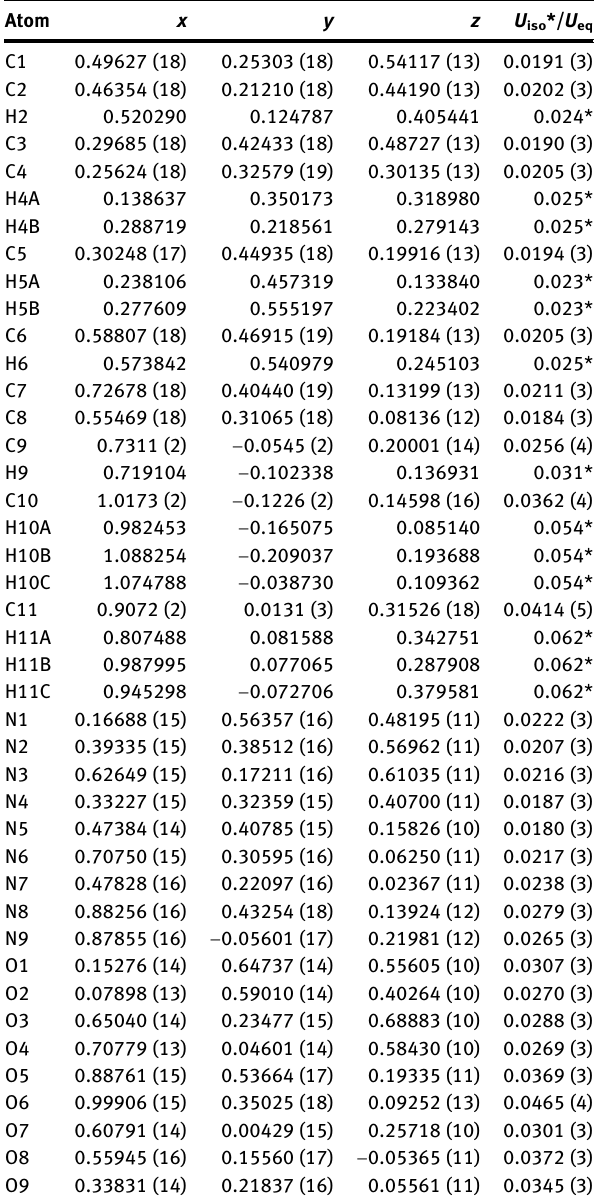
Table  : Fractional atomic coordinates and isotropic or equivalent isotropic displacement parameters (Å 